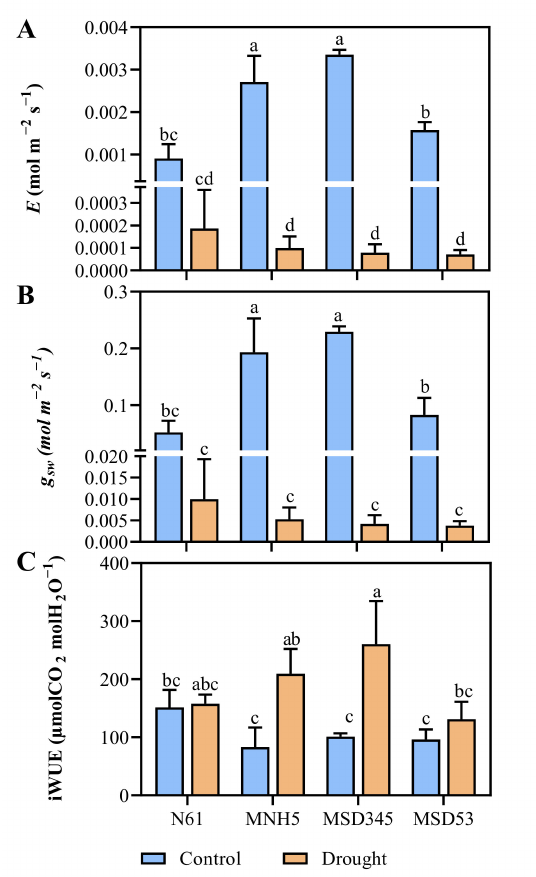
Figure 2. Changes in the transpiration rate ( E ), stomatal conductance ( g sw ), and intrinsic water use e ffi ciency (iWUE) of three multiple synthetic derivative lines (MSDLs) and their backcross parent, “Norin 61” (N61), under control and drought stress conditions: ( A ) E , ( B ) g sw , ( C ) iWUE. Data represent mean of three independent biological replicates at 400 µ mol mol − 1 CO 2 concentration. Error bars represent standard deviation. Values marked with the same letter are not significantly di ff erent ( p < 0.05) between genotypes and conditions according to the Tukey HSD